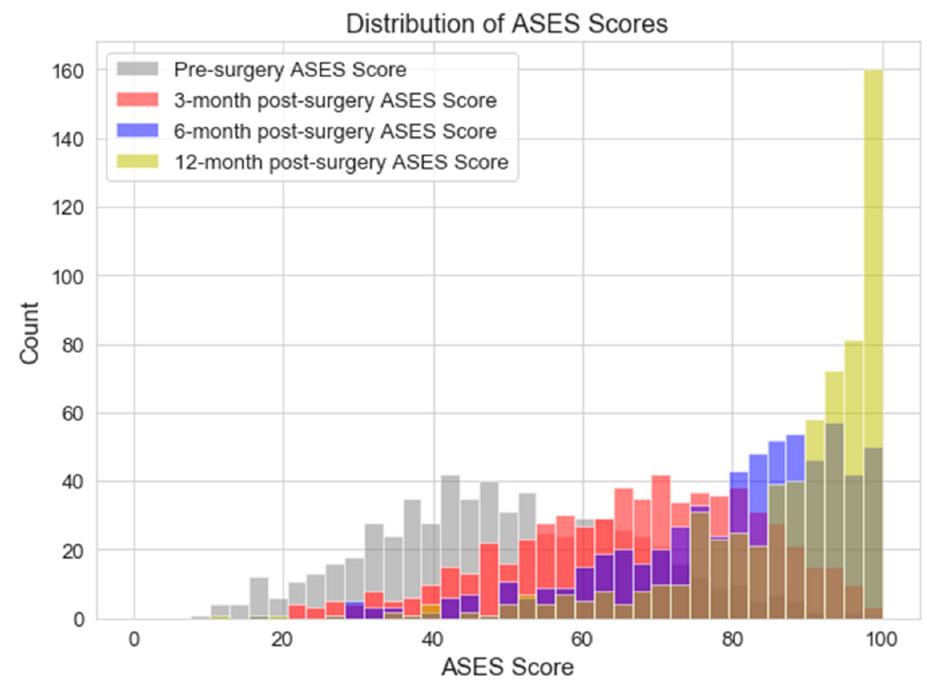
Figure 4. Progressive distribution of the pre-operative, 3-, 6-, and 12-month post-operative ASES scores.